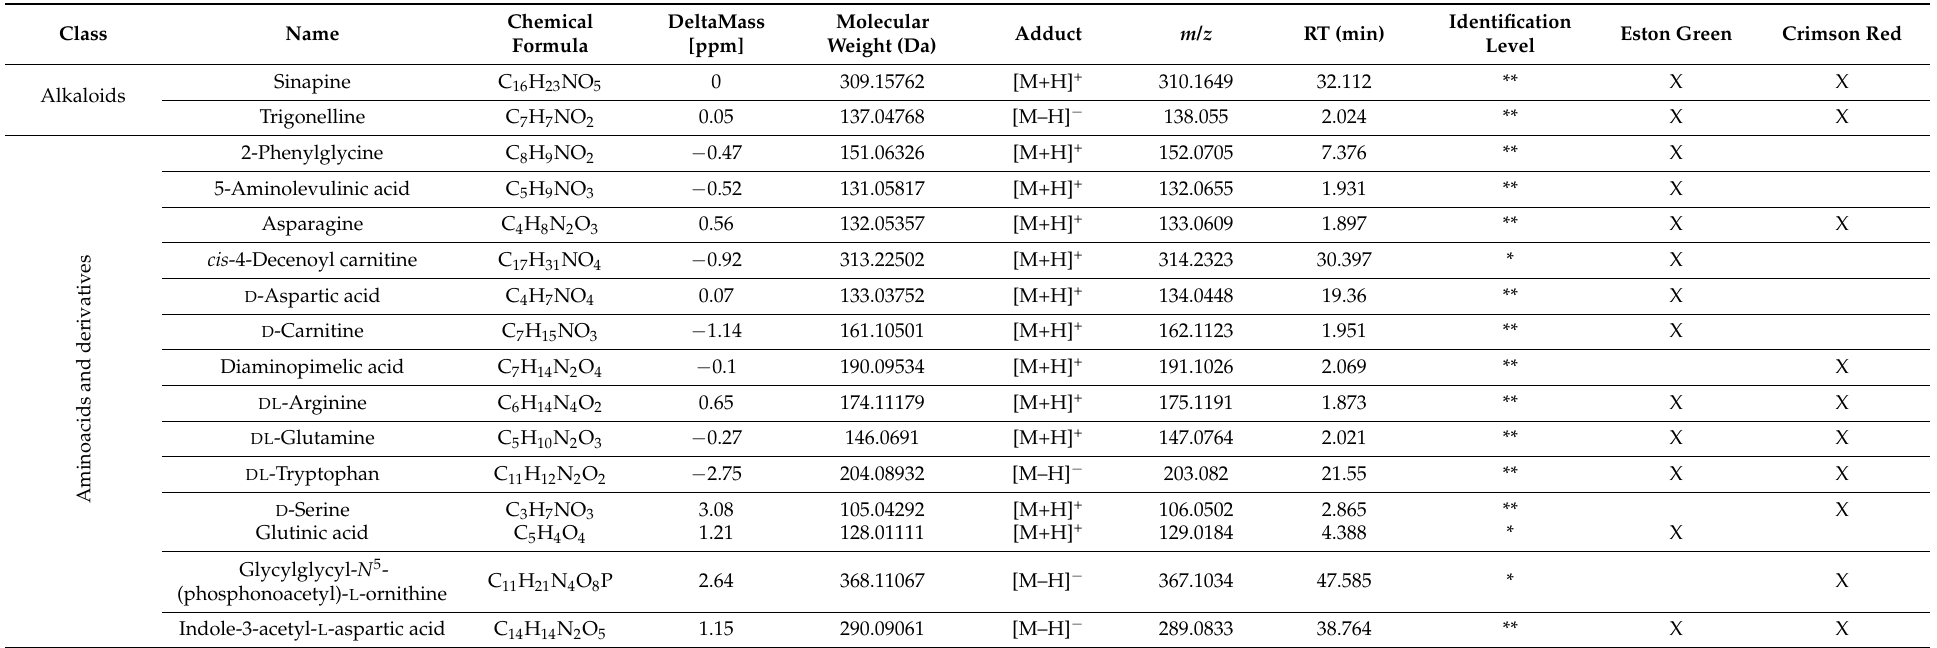
Table 3. Summary of the most relevant molecules that were identified in the hulls of Eston green and Crimson red lentils after processing the respective high- resolution mass spectrometry (HRMS) spectra using Compound Discoverer software. The level of identification medium * (level III—putatively characterized) and advanced ** (level IIa—probable structure) were specified for each molecule along with the class, based on its detection in the green and red variety (X: presence; empty cell: absence) and any other relevant information. For uncommon compounds, the proper retention time (RT) which was observed in each variety was reported, while for compounds that were found in both of the varieties, the RT values referred to Eston Green analysis have been